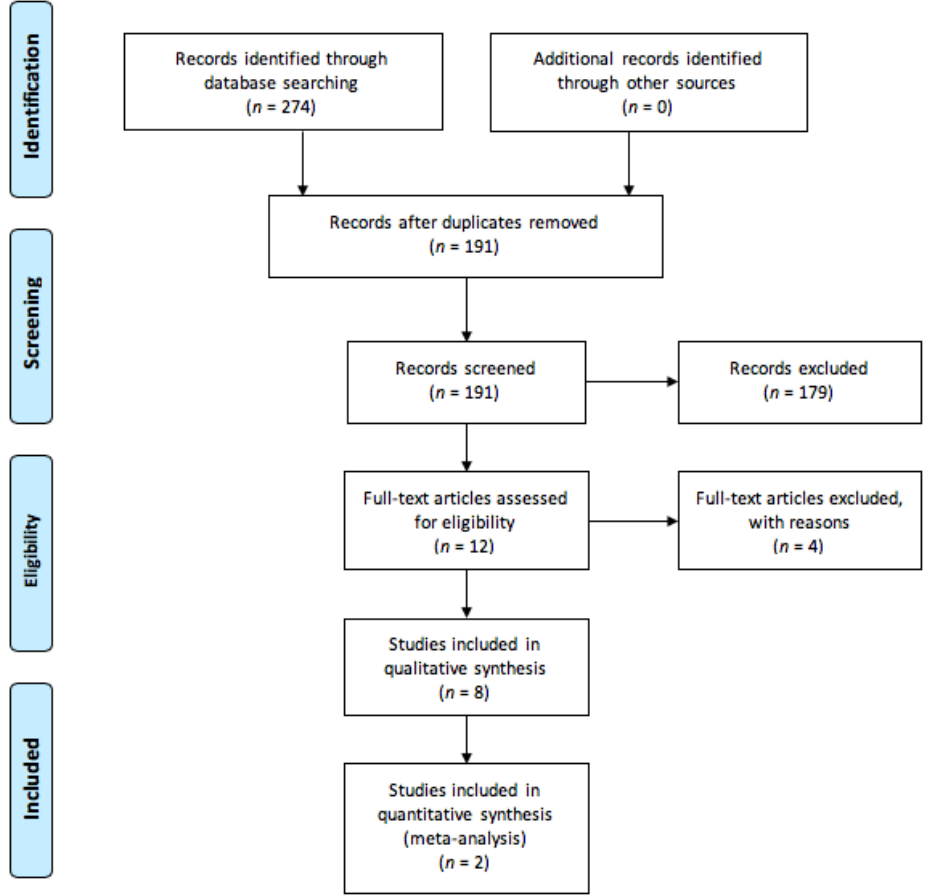
Figure 1. Preferred Reporting Items for Systematic Reviews and Meta-Analysis (PRISMA) study flow diagram describing process of study selection. Reviews or preclinical studies (defined as not providing clinical outcome data) and abstracts were excluded. Full-text articles that provided no outcome of interest were also excluded. Table 1. Characteristics of studies included in the systematic